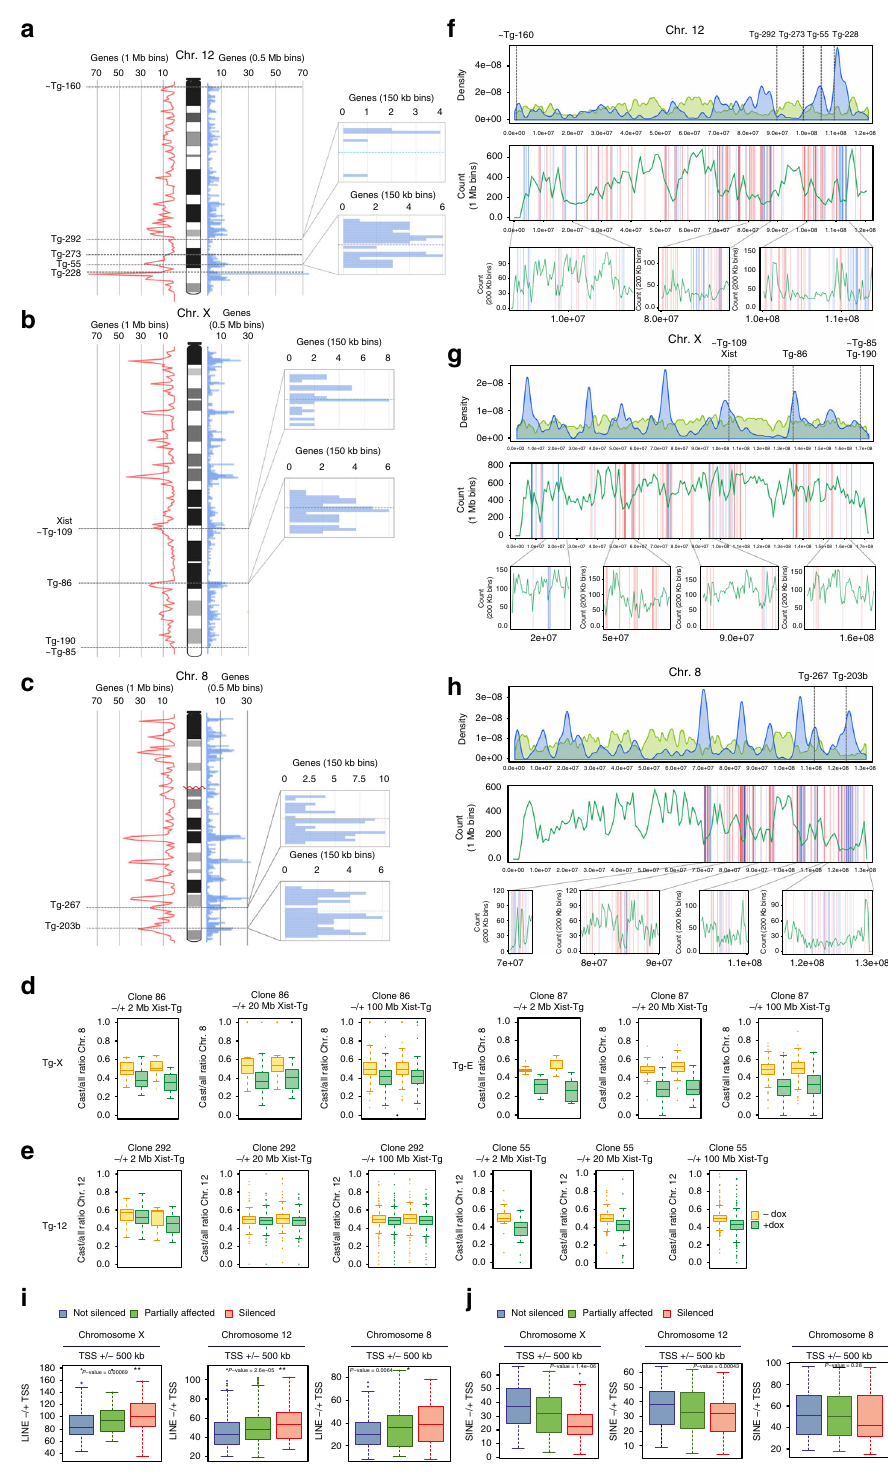
Fig. 6 LINE and gene density on chromosomes X, 8, and 12. a – c Gene density along chromosomes 12 a , X b , and 8 c . Blue histogram bars represent 0.5 Mb bins, red frequency lines correspond to gene distribution in 1 Mb bins. The integration sites of Xist transgenes are indicated and zoom in of the integration loci is shown. Blue histogram bars represent 150 kb bins. d , e Box plots showing the Cast/all ratios of X-linked d and chromosome 12 e genes in 2, 20, and 100 Mb bins around the Xist transgene integration sites as determined by allele-speci fi c RNA-seq analysis. f – h Top : LINE density relative to gene density on chromosome 12 f , X g , and 8 h . Blue , gene density; green , LINE density. Middle : LINE distribution along chromosome 12 f , X g , and 8 h , green frequency lines correspond to LINE distribution in 1 Mb bins along the chromosomes. Blue and red lines indicate “ not silenced ” and “ ef fi ciently silenced ” genes de fi ned in Fig. 5, respectively. Bottom : zoom in of speci fi c loci. Green frequency lines correspond to LINE distribution in 200 kb bins. i Box plot showing LINE density in 1 Mb bins around the TSS of genes belonging to the three different categories de fi ned in Fig. 5. Data for chromosomes 12, 8, and X are shown. * p < 0.05 and ** p < 0.005 Wilcoxon rank-sum test. j as in i but for SINE